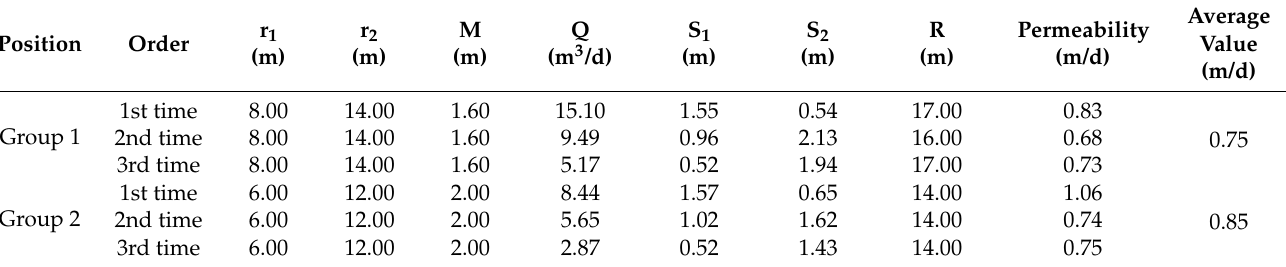
Table 2. Results of the pumping tests at the aquifers.